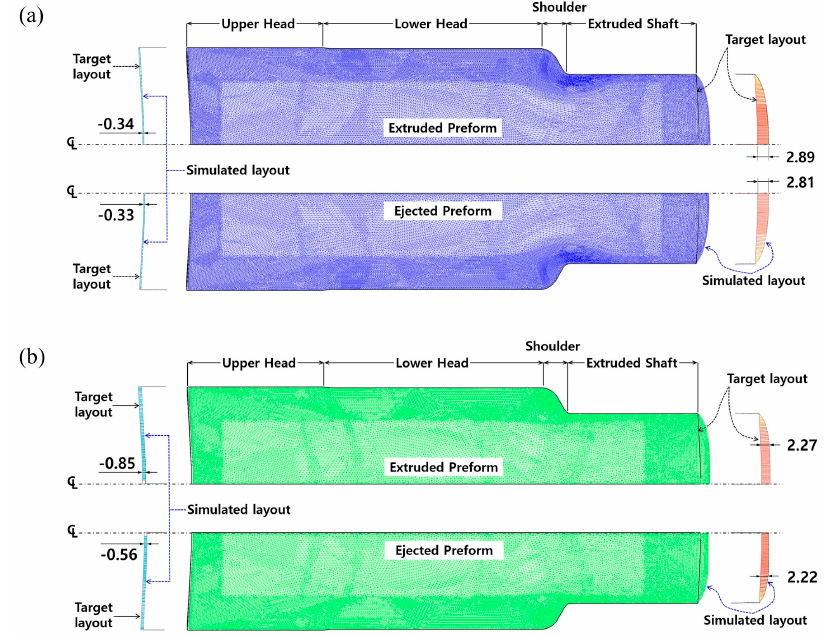
Figure 15. Dimension variation (unit: mm): ( a ) target layout vs. plastic FE simulation, and ( b ) target layout vs. elasto-plastic FE simulation.